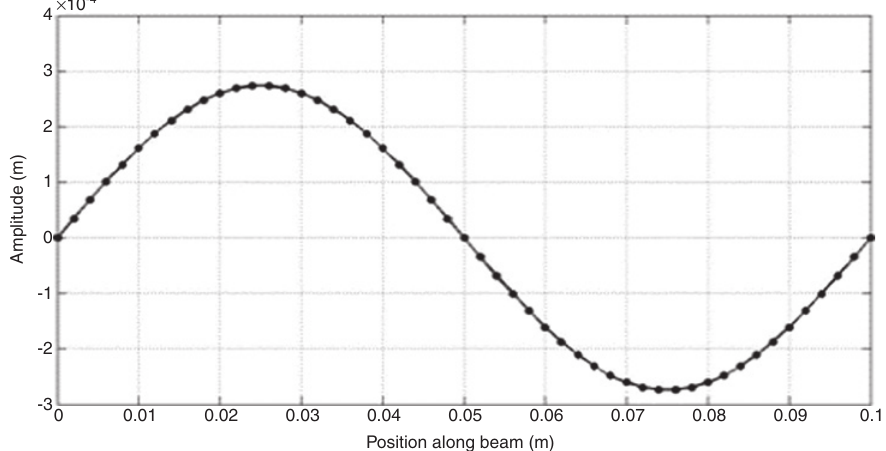
Figure 18: Vibrations of the second characteristic mode of the simply supported beam.